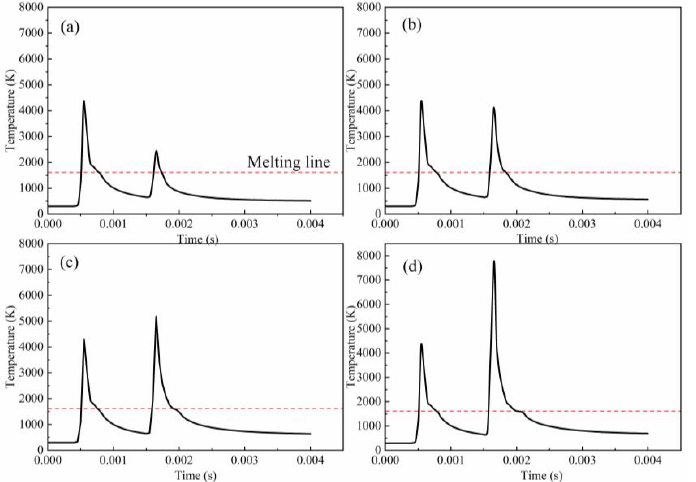
Figure 8. The temperature change of ILP with different ILP power. ( a ) 50 W; ( b ) 90 W; ( c ) 130 W; ( d ) 170 W.